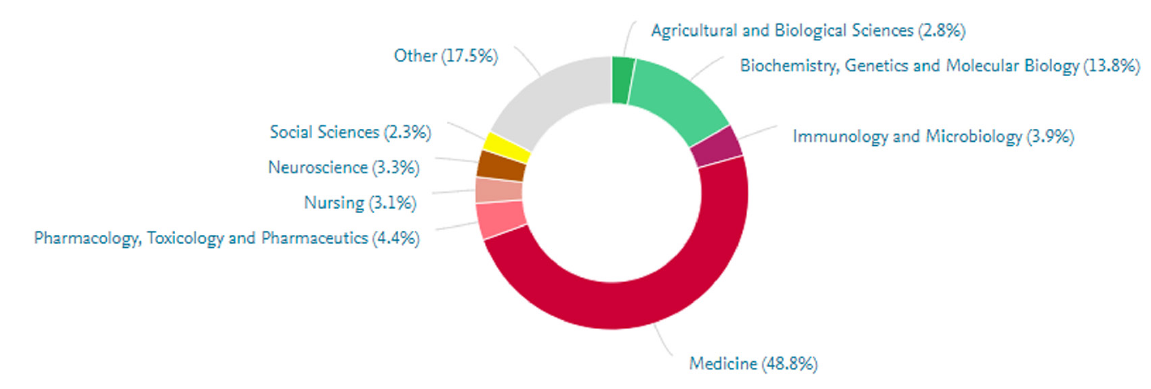
Figure A1. Structural analysis by subjects for “SDG 3”